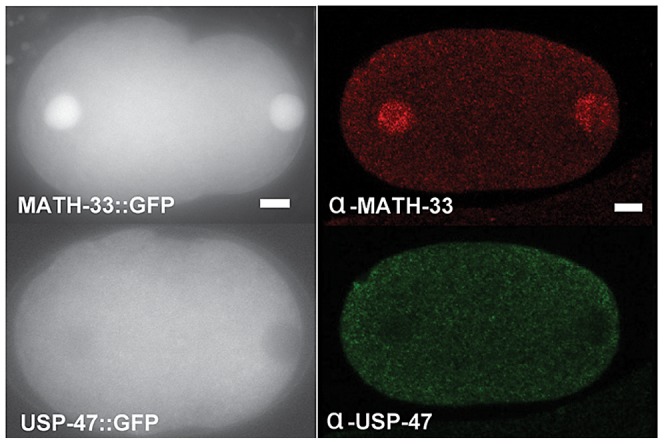
MATH-33 and USP-47 are not enriched at cortex or centrosome.The left panels are representative images of embryos showing the distribution of GFP::MATH-33 and GFP::USP-47 in one-cell embryos. Both proteins are present in the cytoplasm, but MATH-33 is enriched in nuclei. The right panels are images of embryos showing immunostaining of endogenous MATH-33(red) in the cytoplasm and the nucleus; USP-47(green) primarily in the cytoplasm. Scale bar represents 5 µm.